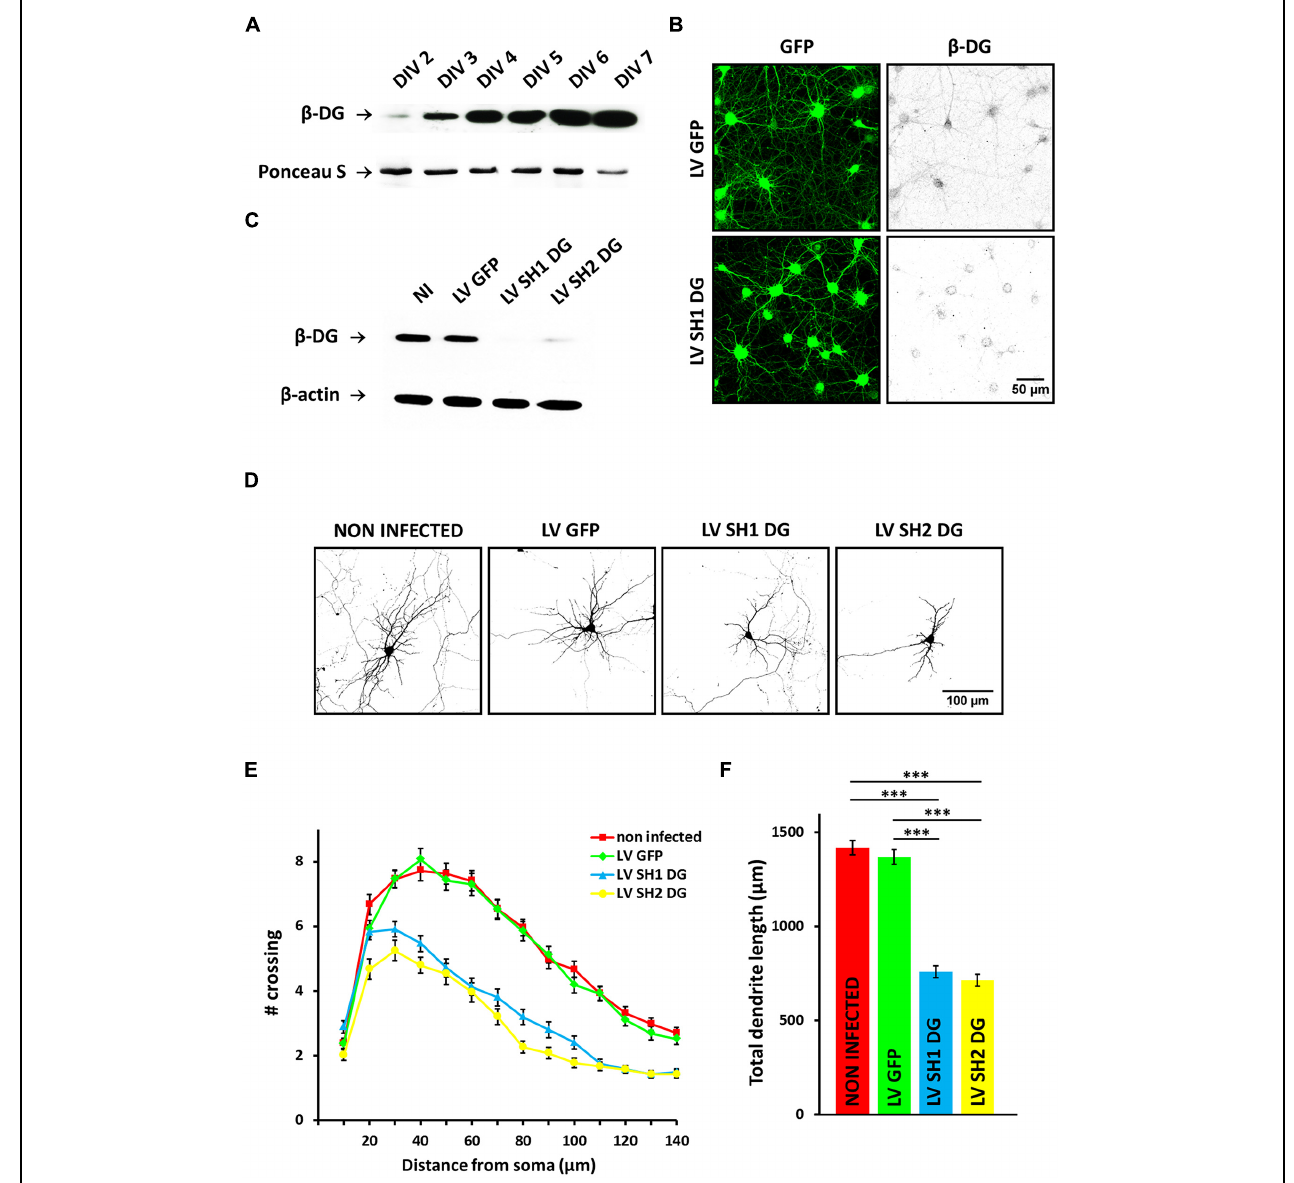
FIGURE 1 | Knockdown of dystroglycan (DG) impairs dendritic tree development. (A) Time-course of the DG expression in primary hippocampal cultures – representative western blot analysis is shown. (B) Confocal images of hippocampal neurons infected with either empty lentivirus [LV green fluorescent protein (GFP)] or a lentivirus that carries short-hairpin RNA (shRNA) for DG (LV SH1 DG) and immunostained with anti- β -DG antibody. (C) Western blot analysis of β -DG expression in protein lysates from non-infected neurons (NI) and neurons infected with LV GFP, LV SH1 DG, or LV SH2 DG. β -actin served as a loading control. (D) Representative images of neurons used for the